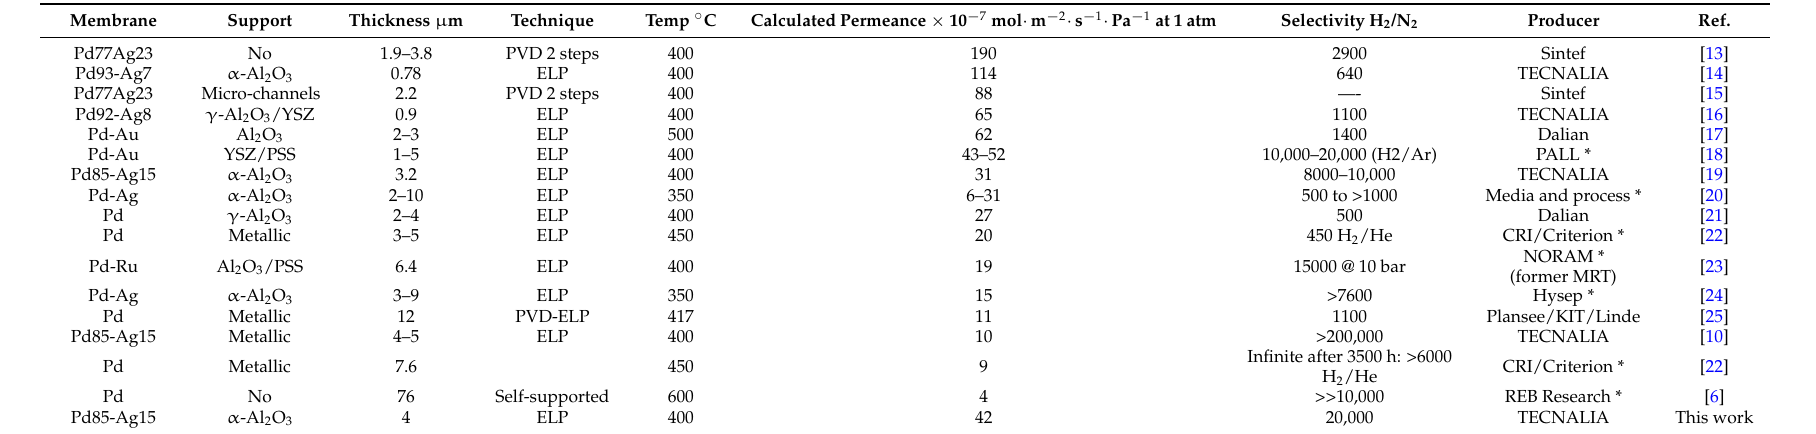
Table 1. Hydrogen permeation properties of commercial and the best thin Pd based membranes (membranes reported in order of permeance, the units of the permeance have been taken from DOE 2015 [12] and used to compare the different